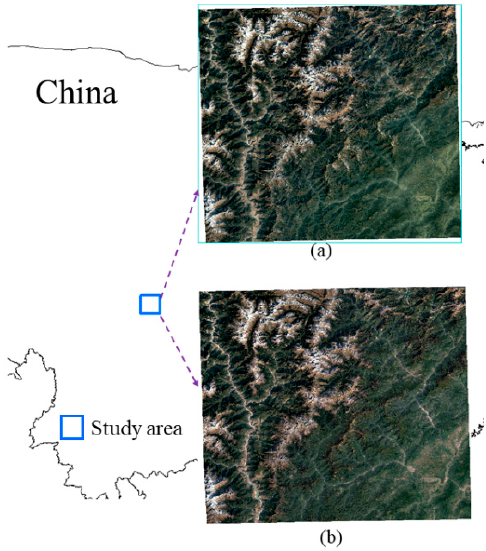
Figure 5. Study area demonstration: ( a ) image of earthquake impacted area in Lushan County, taken on 31 December 2010; ( b ) image taken on 31 December 2013.